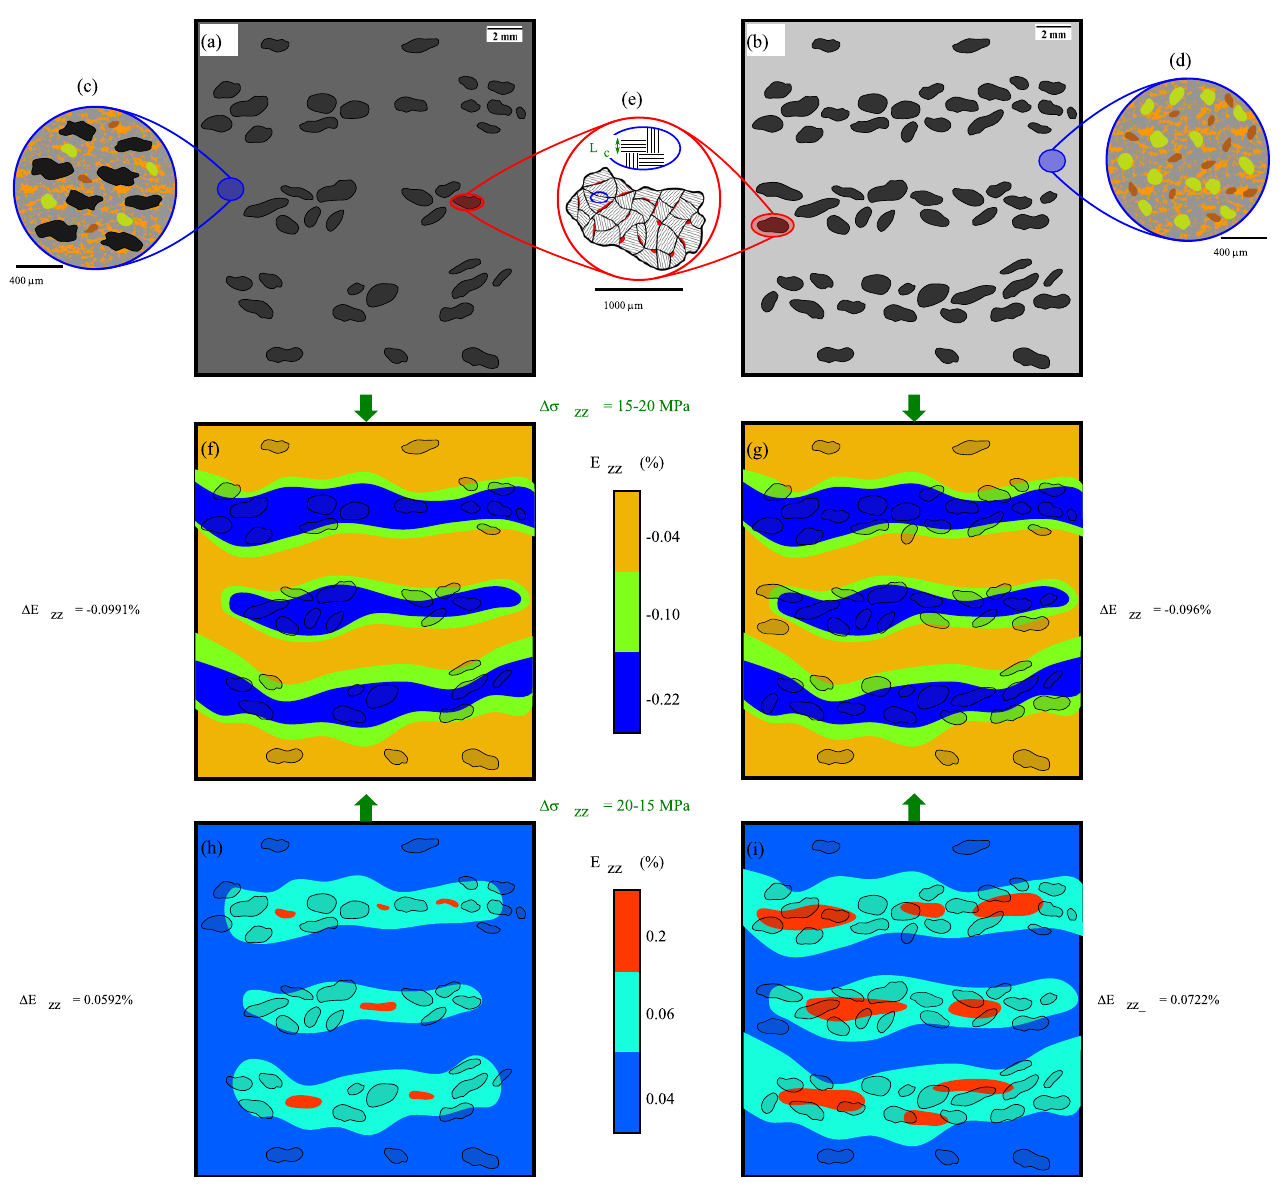
Figure 10. Schematic illustrations of the components at ( a ) the macroscale of RM, ( b ) the macroscale of MMCsG2 material, ( c ) the mesoscale of RM material, ( d ) the mesoscale of MMCsG2 material, and ( e ) the microscale of a G2 particle. Schematic illustrations of the compressive behaviour of ( f ) the RM during the loading interval of ∆ σ = 15–20 MPa, ( g ) the MMCsG2 material during the loading interval of ∆ σ = 15–20 MPa, ( h ) the RM during the unloading interval of ∆ σ = 20–15 MPa, and ( i ) the MMCsG2 material during the unloading interval of ∆ σ = 20–15